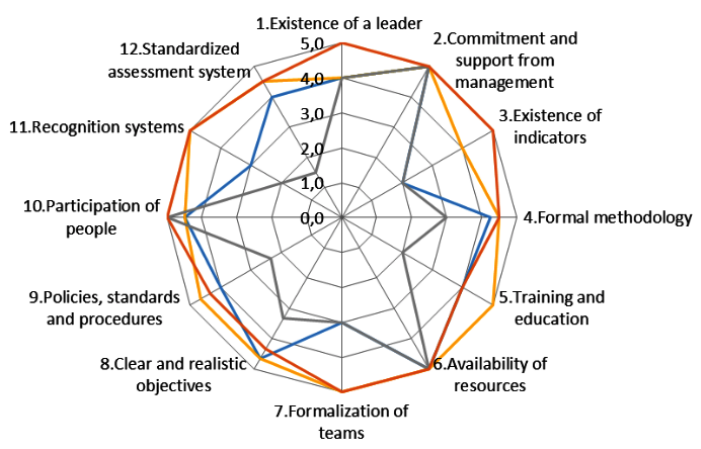
Figure 1. Results of the assessment of the key success factors for companies C1, C2, C3 and C4